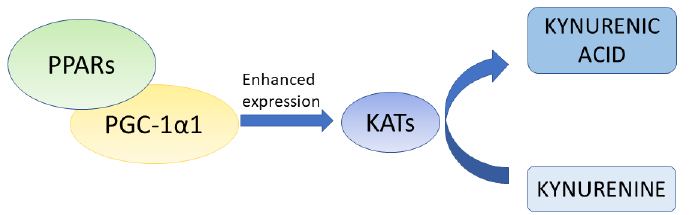
Figure 3. The simplified scheme of interaction between the PPAR pathway and the kynurenine pathway in skeletal muscles [73]. PGC-1 α 1 may interact with various transcription factors, including PPARs, and plays a crucial role in the interaction between the PPAR pathway and the kynurenine pathway. In skeletal muscles, PGC-1 α 1 induces the expression of KATs, which convert kynurenine to kynurenic acid. KATs—kynurenine aminotransferases, PGC-1 α 1—peroxisome proliferator-activated receptor gamma coactivator-1 alpha 1, PPARs—peroxisome proliferator-activated receptors.